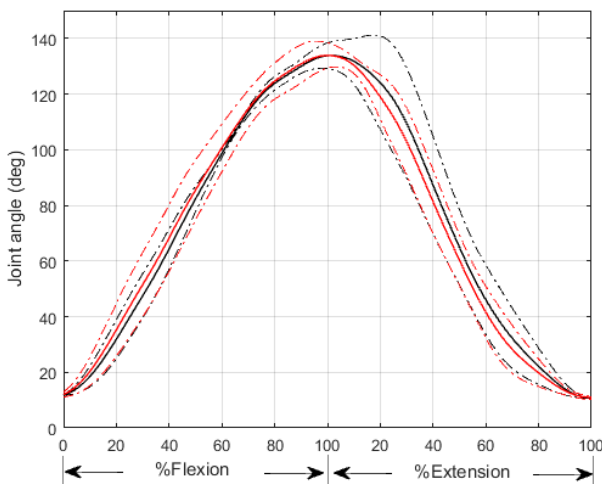
Figure 6. Comparison between experimental and estimated joint angle. The black and red solid lines represent the average experimental and estimated joint angles respectively. The black and red dash dotted lines represent the standard deviations of the experimental and estimated joint angle respectively. The average elbow flexion-extension duration is about 5.8 s.